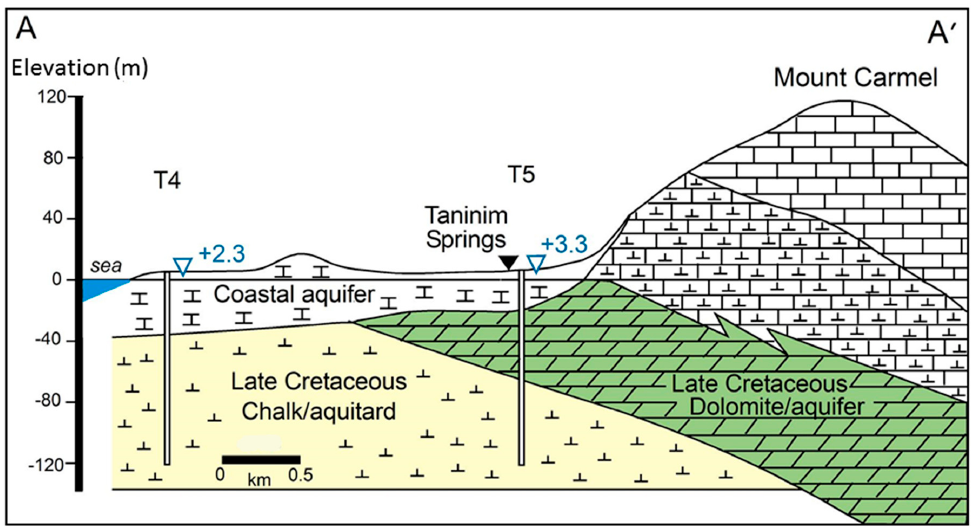
Figure 3. Hydrogeological section in the research area (A–A’ in Figure 1), modified after [35]. The coastal aquifer overlays Late Cretaceous limestone and dolomite aquifer in the east and chalk aquitard in the west. The dolomite aquifer (green) is the main source to the Taninim springs. The upper units in the Mount Carmel area, consisting of limestone and chalky limestone, are also of Late Cretaceous age. The blue number indicates the pre-utilization heads.